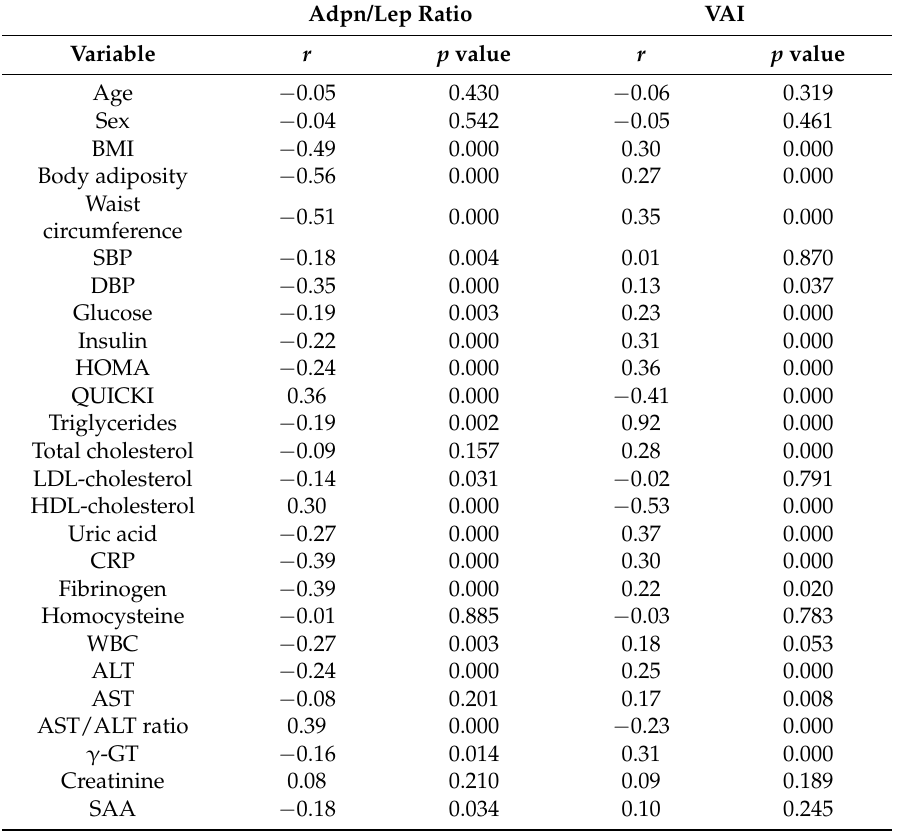
Table 3. Analysis of the correlation between several anthropometric and cardiometabolic variables and the markers of adipose tissue dysfunction Adpn/Lep ratio and visceral adiposity index